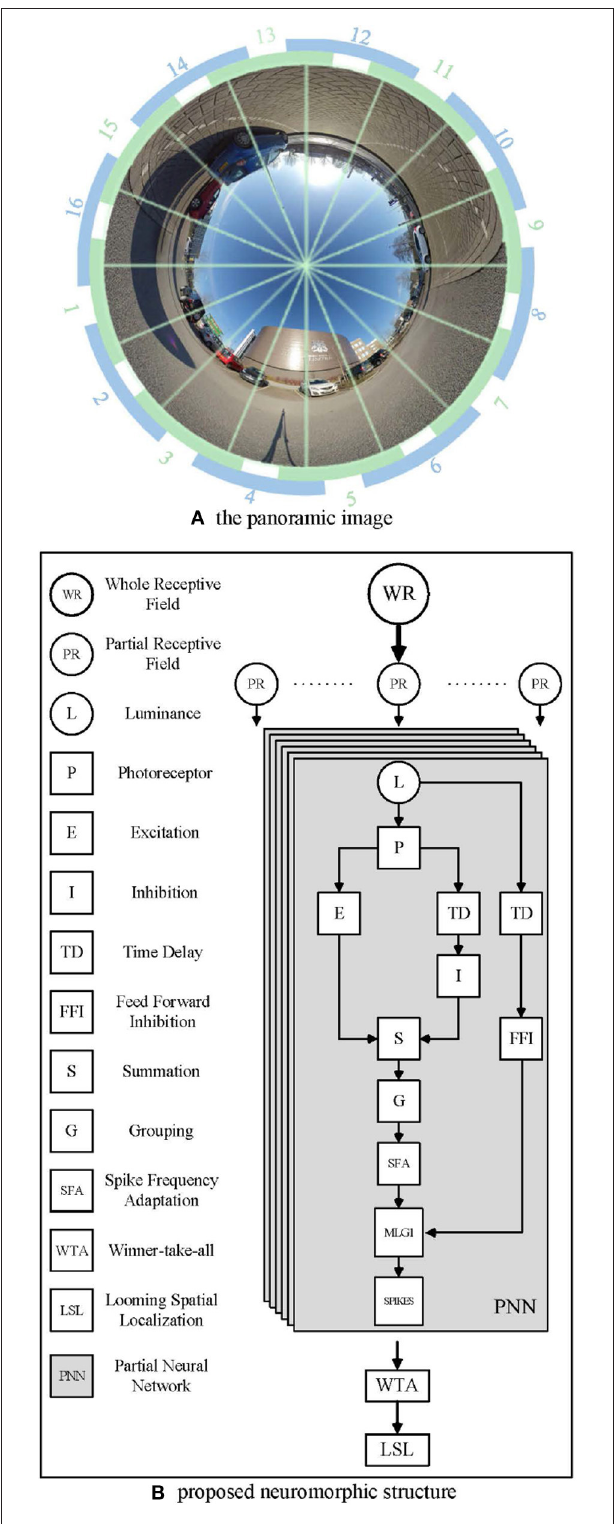
FIGURE 3 | Example images from the panoramic camera. (A) The panoramic image divided in 16 equal segments. The proposed method involves